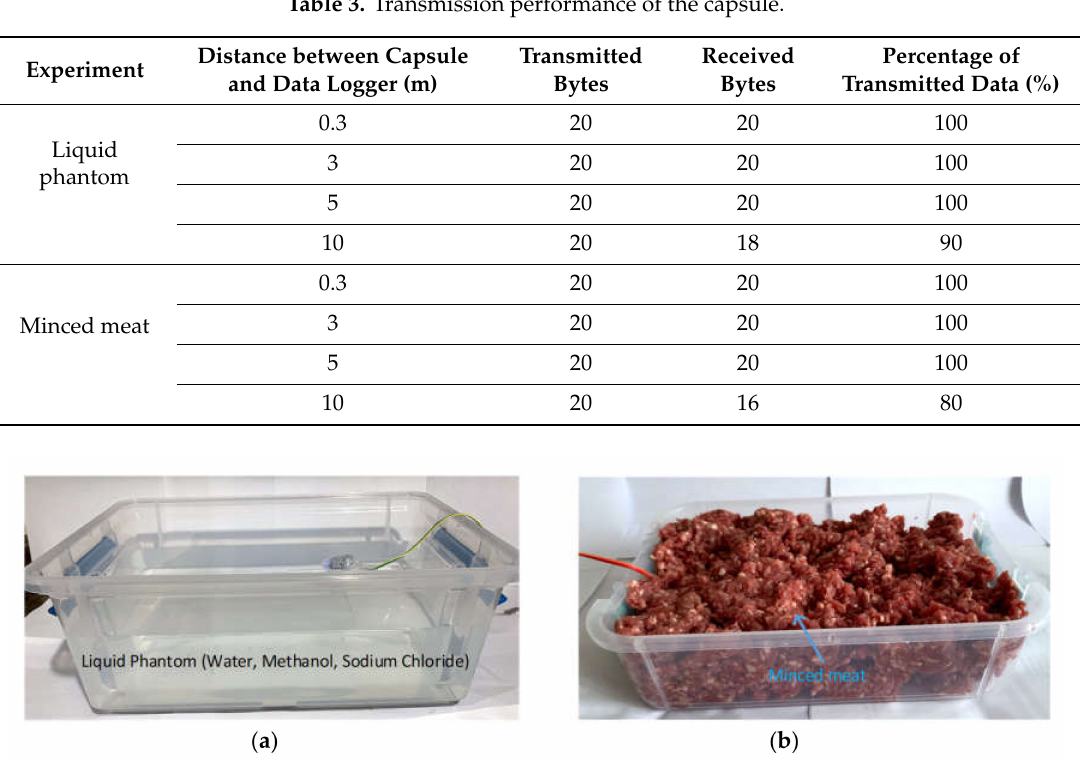
Figure 12. Measurement setup to test the transmission rate of the proposed capsule in: ( a ) liquid phantom; ( b ) minced